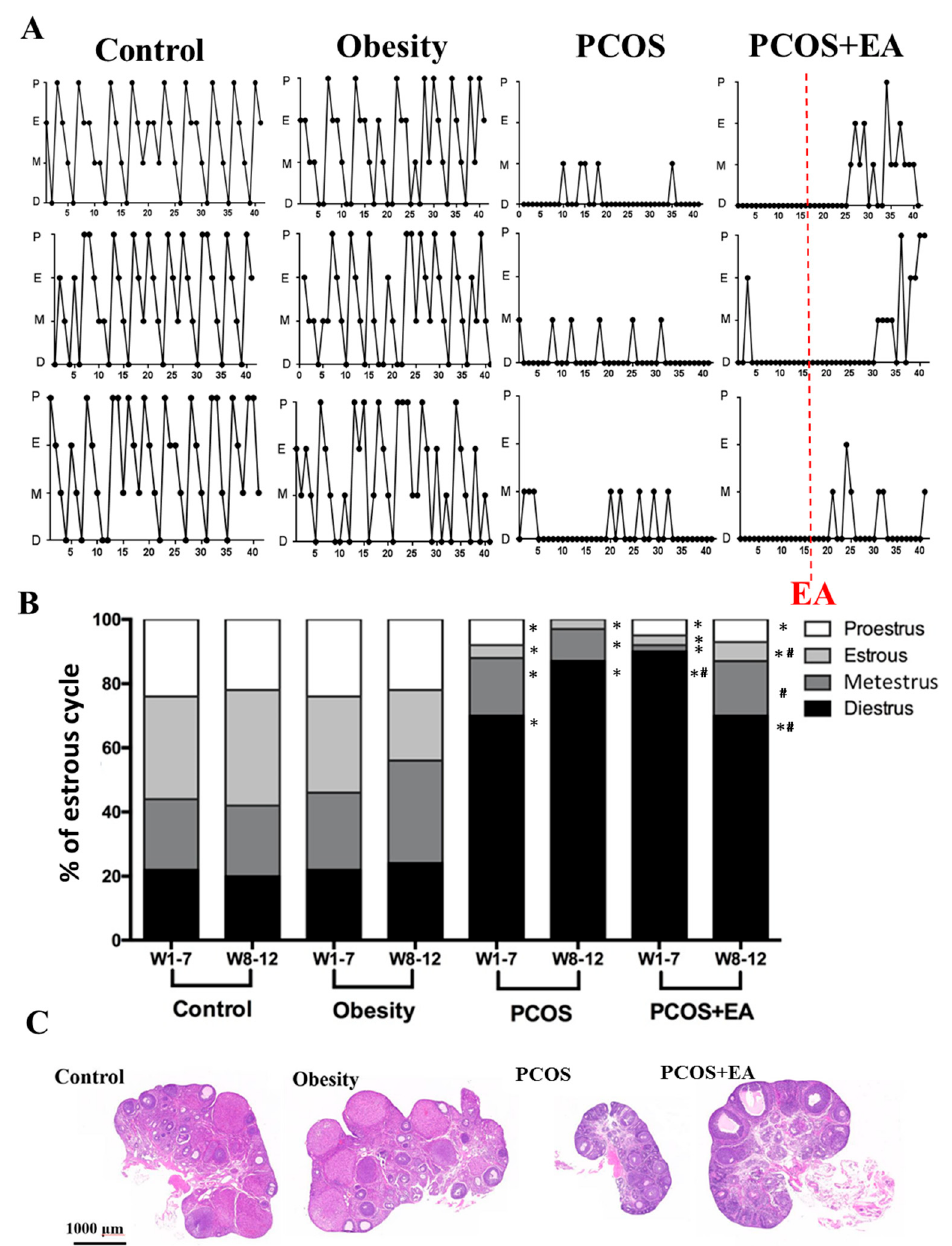
Figure 1. Pathological manifestations of the 5 α -dihydrotestosterone (DHT)-induced polycystic ovary syndrome (PCOS) rat model and the effect of electro-acupuncture (EA). ( A ) Three typical oestrous cycle charts of rats from each group, P: Proestrus; E: Oestrus; M: Metestrus; D: Diestrus. ( B ) The ratio of Proestrus, Oestrus, Metestrus, and Diestrus stage to all observed oestrous cycles. All values are the mean ± standard error; * p < 0.05 vs. control group; # p < 0.05 vs. PCOS group. ( C ) Hematoxylin and eosin staining of paraffin-embedded sections from each group.